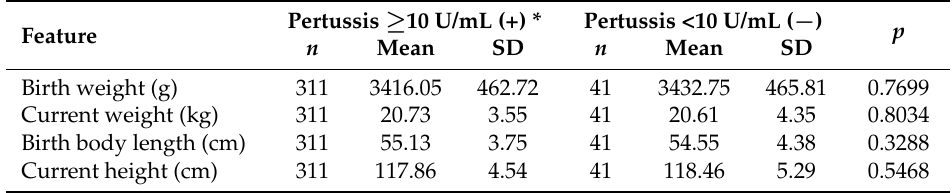
Table 1. Pertussis antibody titre and anthropometric